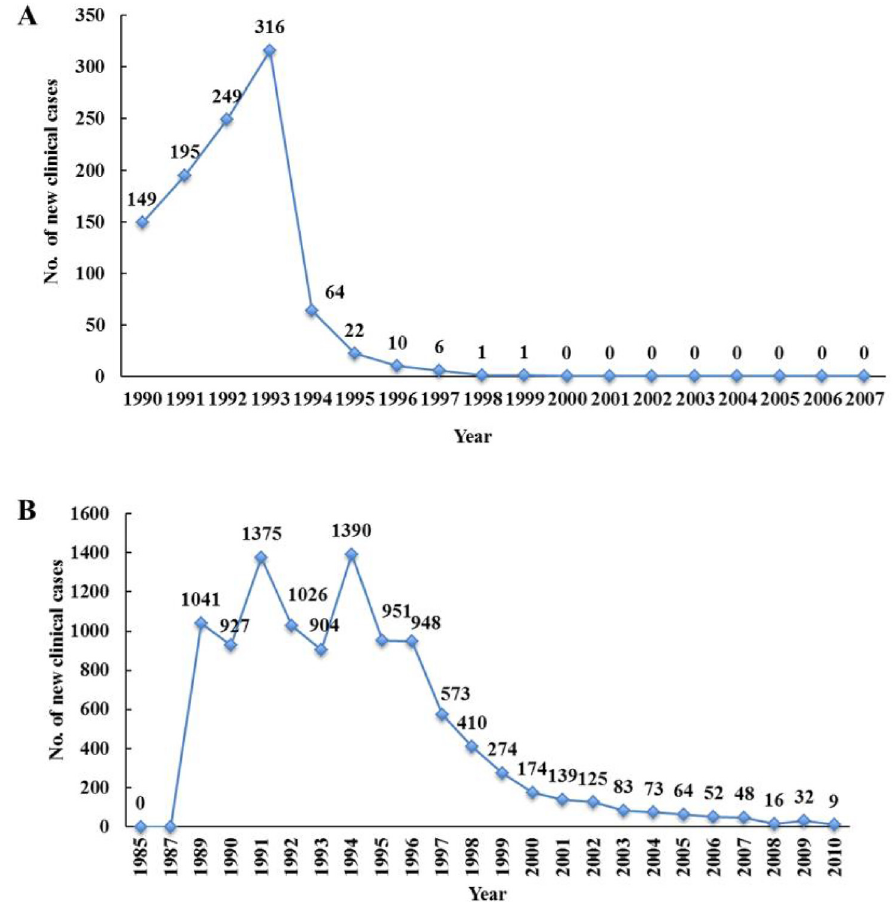
Fig 4. Number of new clinical cases in two endemic foci: The number of new clinical cases, (individuals diagnosed for the first time as positive by Mazzotti reaction, nodules, or skin biopsies) in the Oaxaca focus (Panel A) in the Southern Chiapas focus (Panel B; Figure taken from Rodriguez- Perez et al., 2013 [18]). The number of new clinical cases in the Northern Chiapas focus can be found in Fig 2 of Rodriguez-Perez et al., 2010